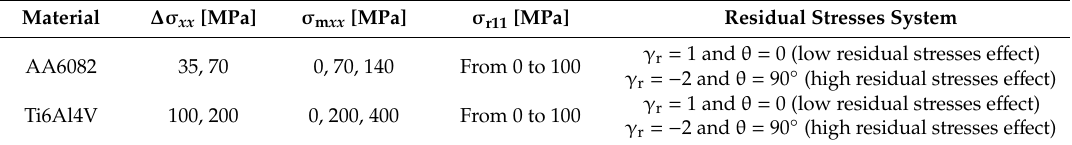
Table 3. Ranges of stress values used for modelling AA6082 and Ti6Al4V alloys.